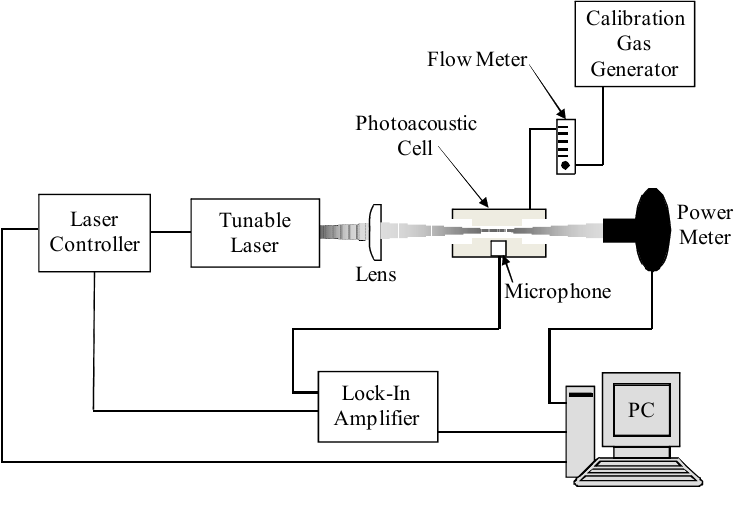
Figure 1. Schematic diagram of a general photoacoustic gas sensor